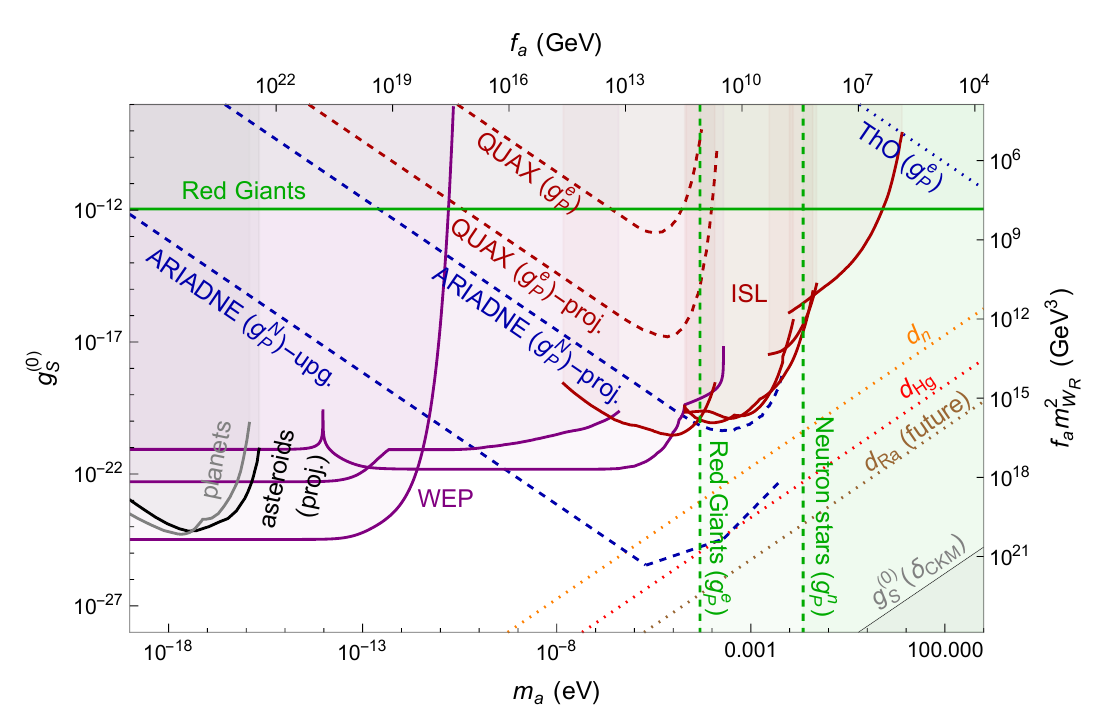
Figure 5 . Constraints on the isoscalar axion-nucleon coupling in the left-right model discussed in section 7.3. The CP-even axial axion-fermion couplings are chosen as in the DFSZ model with tan β = 1 . To obtain the mass scale, m , on the right vertical axis, we assumed ξ sin α = W R 1+ ξ 2 m b /m t sin α (see refs. [144, 145]) and pick sin α = 1 . The labelling of the lines is explained in